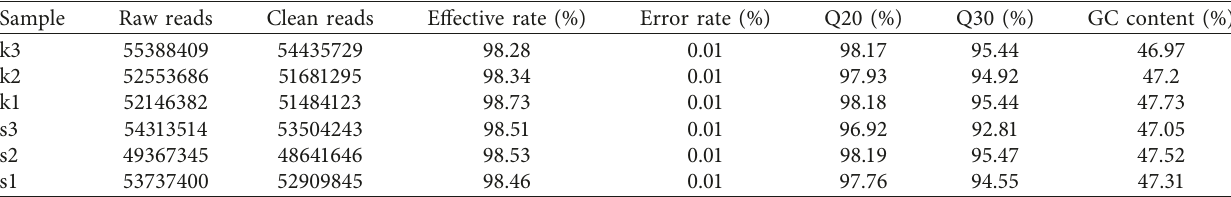
Table 1: The results of quality control for the sequencing data.